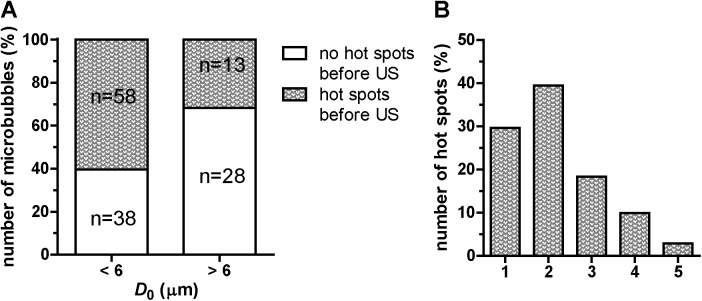
Homogeneity of the fluorescent microbubble coating before insonification.(A) Number of microbubbles with hot spots (n = 137 microbubbles). (B) Number of hot spots per microbubble coating (n = 71 microbubbles). Hot spots were defined as focal areas of increased fluorescence intensity.